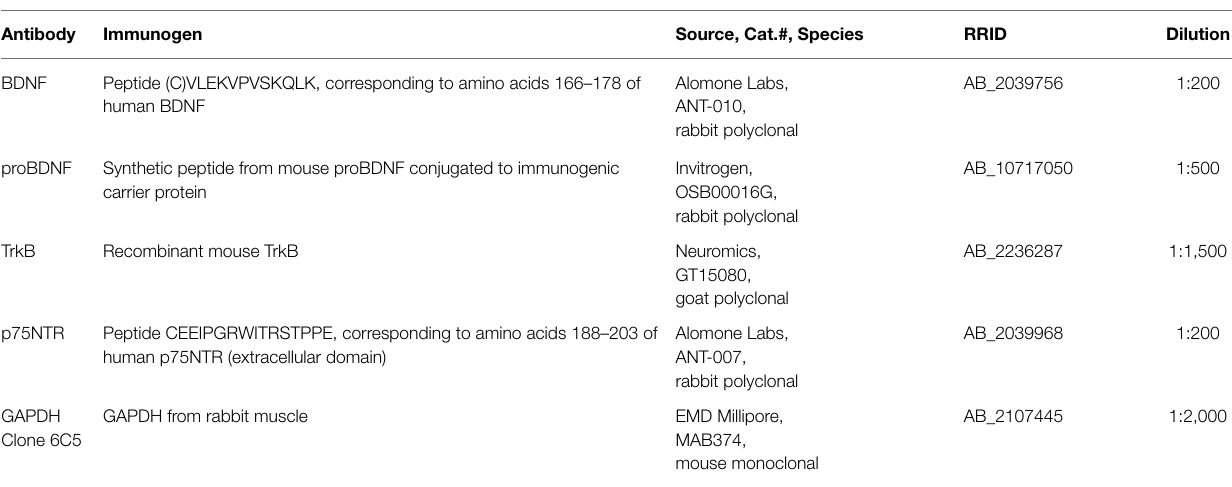
TABLE 1 | Primary antibodies.